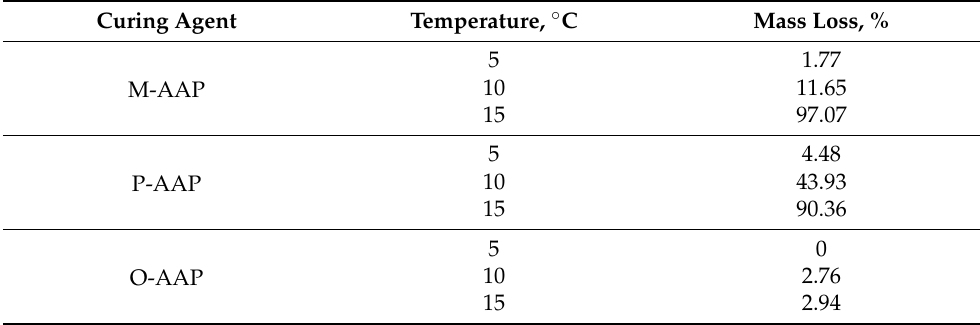
Table 1. Dependence of gel fraction content in cured epoxy compositions depending on the content of modifier therein.